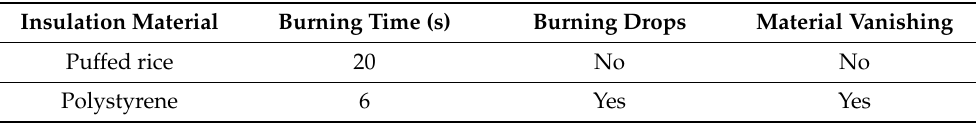
Table 3. Evaluation of the puffed rice and polystyrene insulation materials according to burning time, gas emission, and appearance of burning